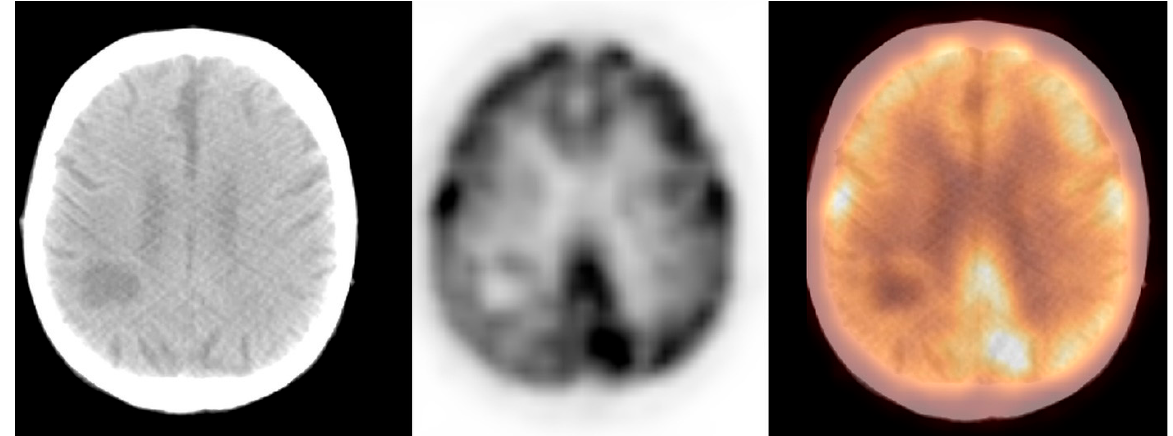
Figure 4. Incidental finding of a hypodense and photopaenic area in the right parietal lobe, consistent with primary brain tumour, in a patient with larynx cancer (source: original figure). Description: axial view of the brain and torso [ 18 F]FDG PET/CT over the middle cranial fossa—low-dose CT ( left -hand side image), PET ( middle image), and PET/CT fusion ( right -hand side image).